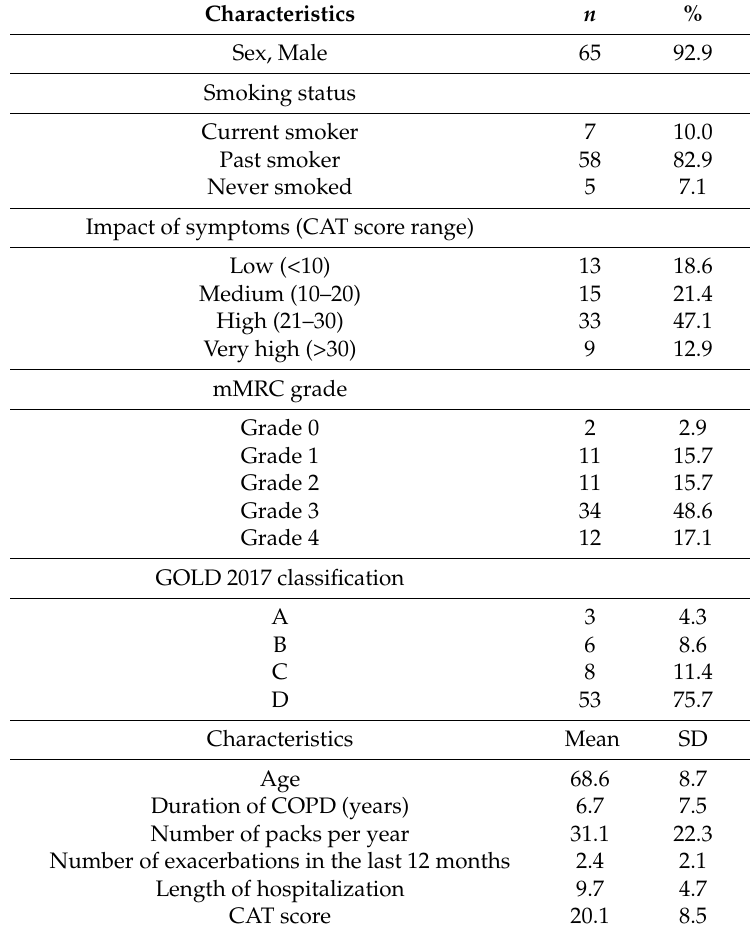
Table 1. Sociodemographic and chronic obstructive pulmonary disease (COPD)-related characteristics ( n =